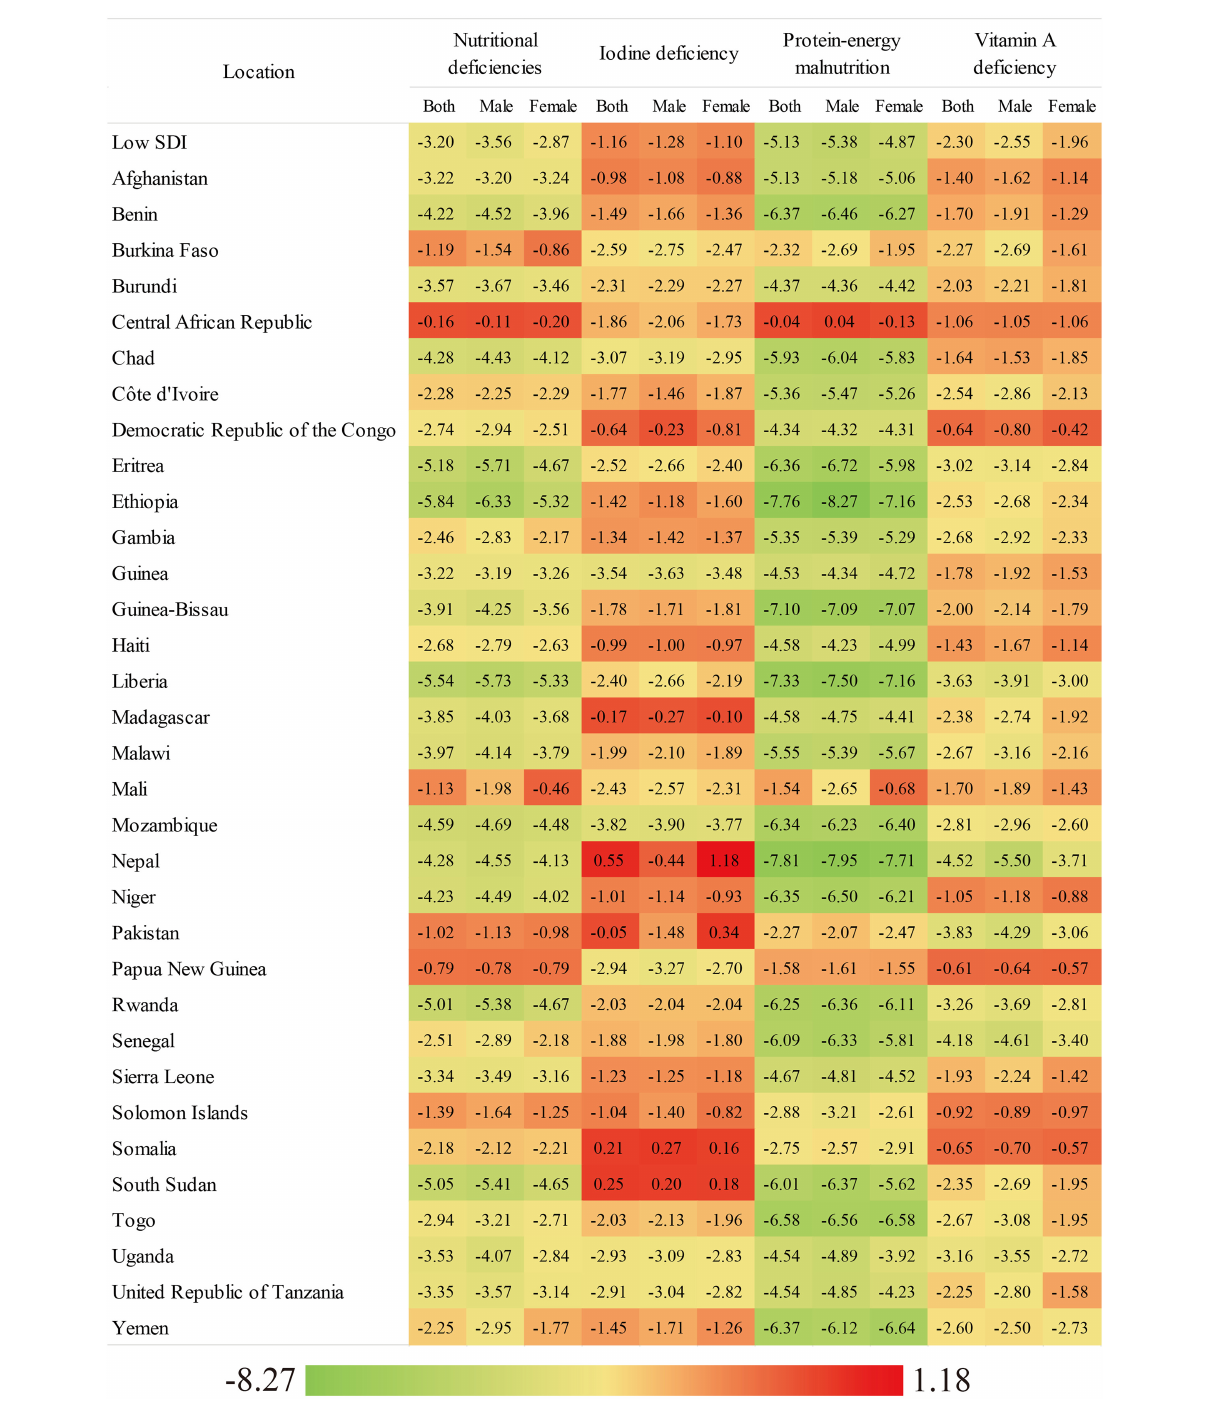
FIGURE3 The EAPC of age-standardized DALYs rate of overall nutritional deficiency and its main subcategories from 1990 to 2019, by gender and country.